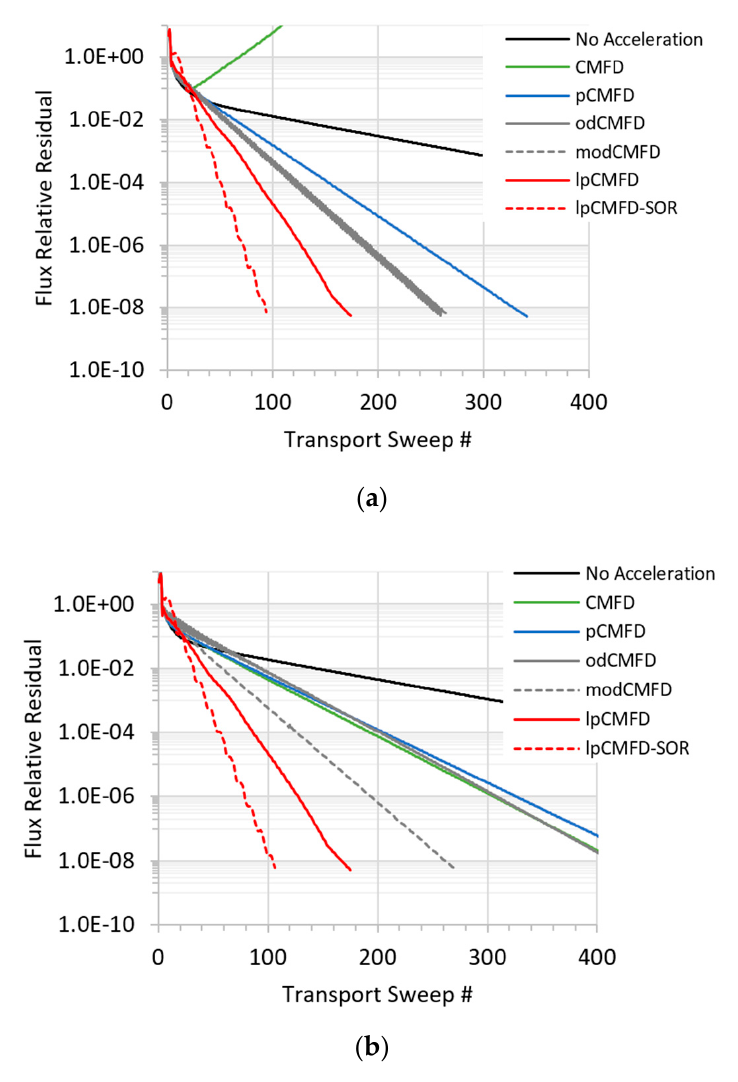
Figure 9. Results of the 2D test problem. ( a ) Case A ( (cid:1855) = 0.9 ); ( b ) Case B ( (cid:1855) = 0.7 ).